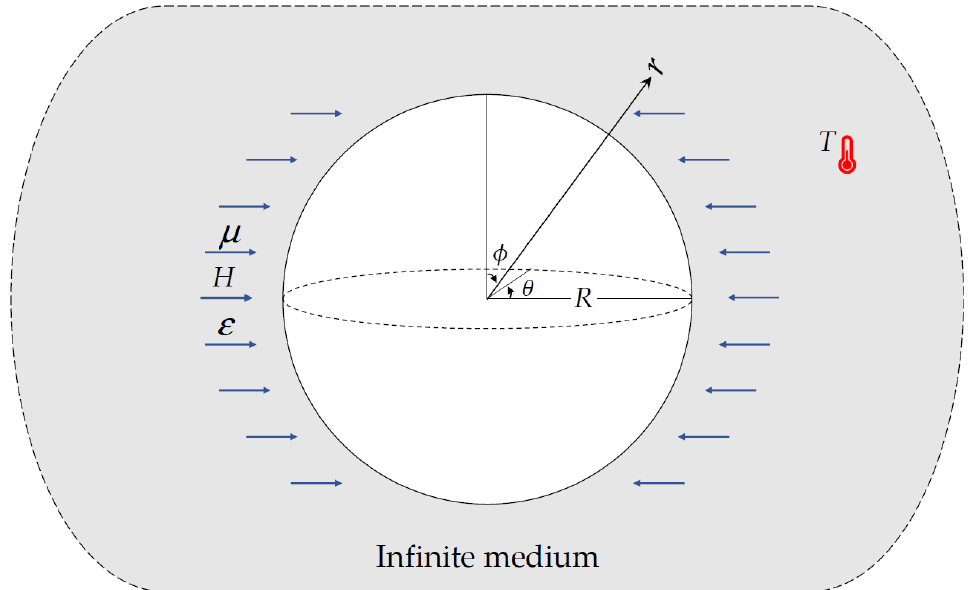
Figure 1. An infinite environment with constant heat and magnetic field that affect externally on the spherical hole.